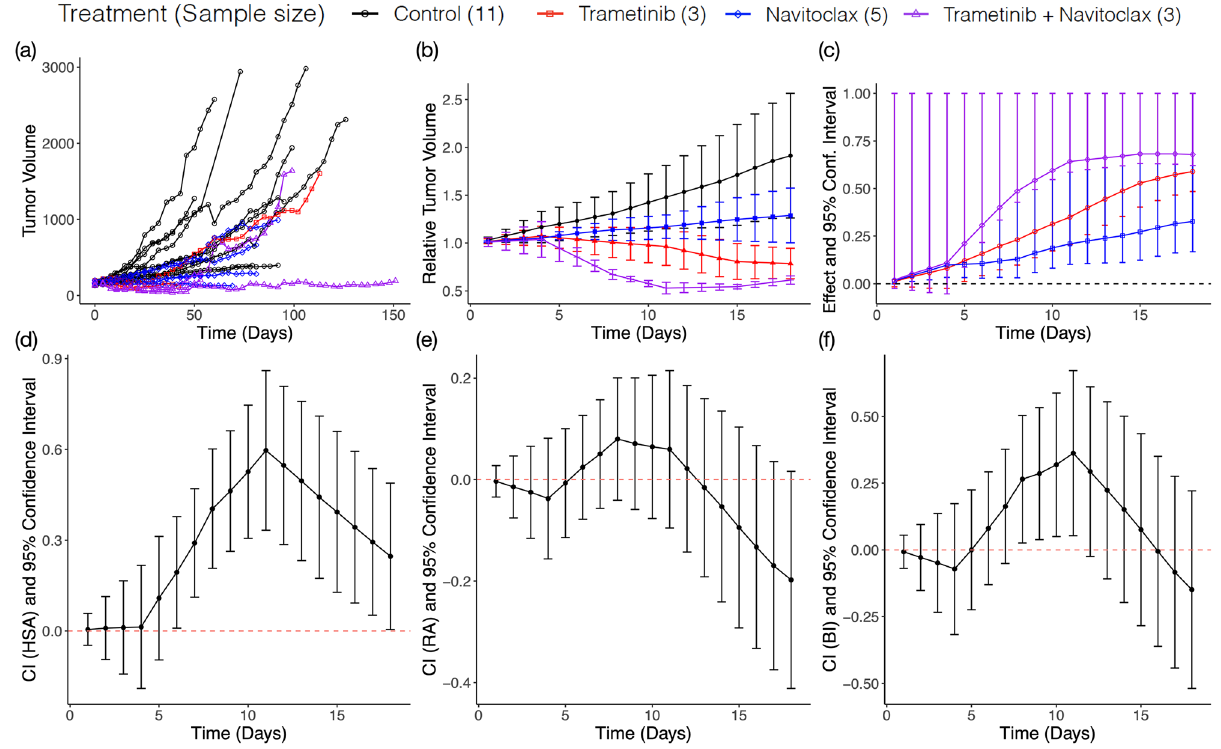
Figure 2. Effect and Combination Indices for trametinib plus navitoclax. ( a ) Profile plot of tumor volume. ( b ) Profile plot of relative tumor volume. Y-axis shows the mean ± standard error of relative tumor volume within each treatment group. ( c ) The drug effect for each treatment group relative to control group is quantified by tumor growth inhibition (TGI). The vertical line indicates the one-sided 95% confidence interval. ( d – f ) The joint action of combination drug under each reference model (HSA, RA, and BI) is assessed using a combination index. The vertical line indicates the two-sided 95% confidence